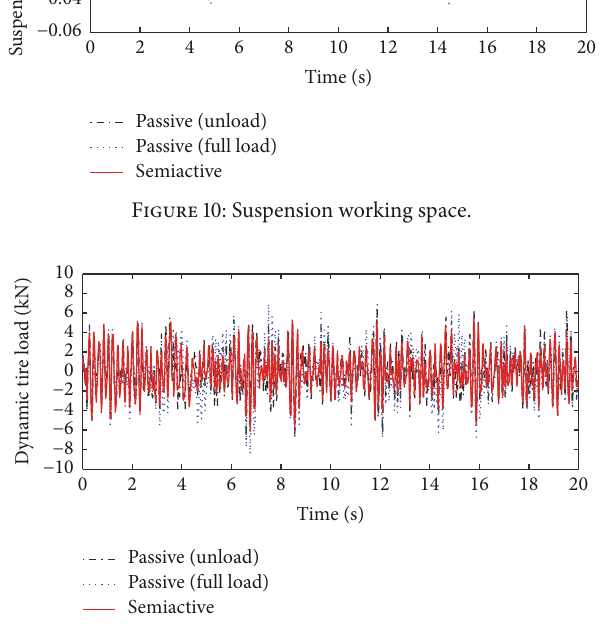
Figure 11: Dynamic tire